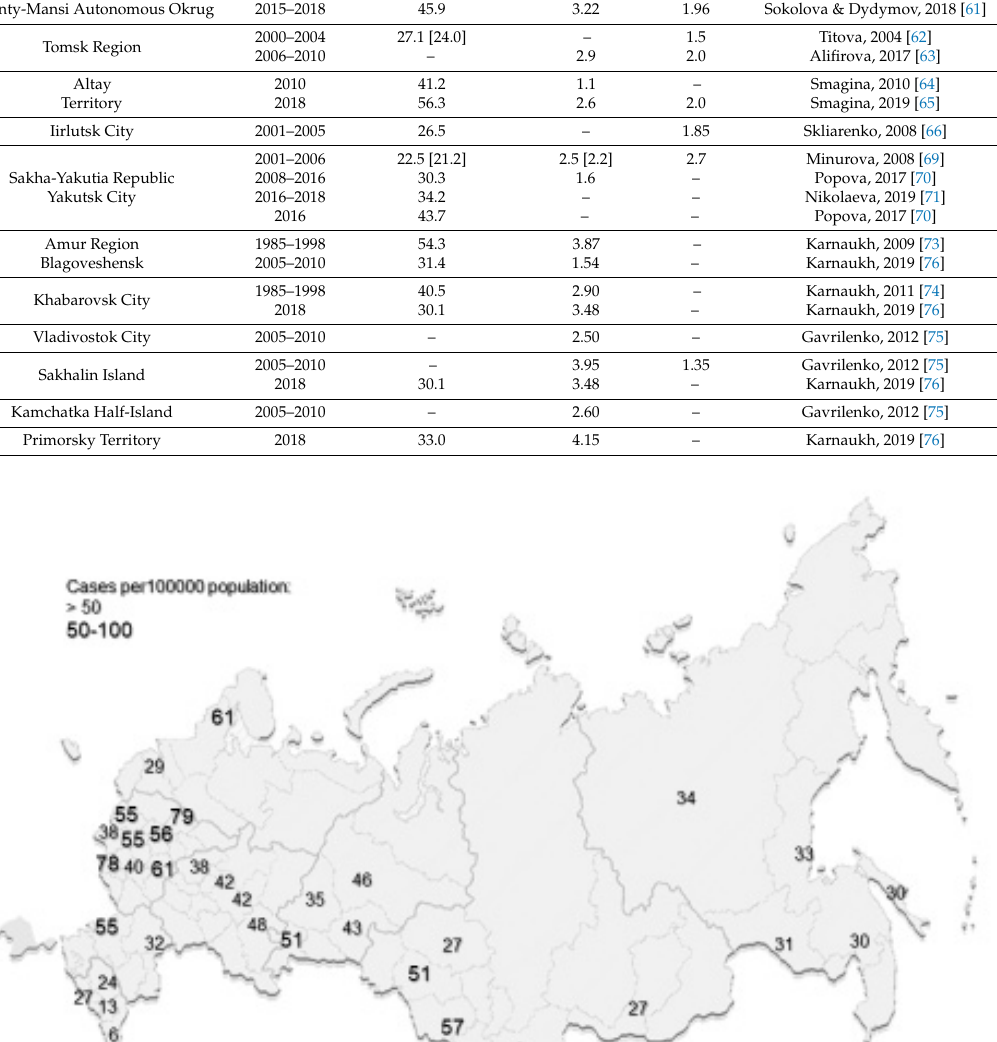
Figure 3. The latest data on MS incidence per 100,000 population in regions of the Russian Federation. Author Contributions: A.B. conducted data collection, design, writing, overall preparation of the manuscript and synthesis. M.M. participated in writing, preparation of the manuscript. Funding: This research received no external funding. Conflicts of Interest: The authors declare no conflict of interest.